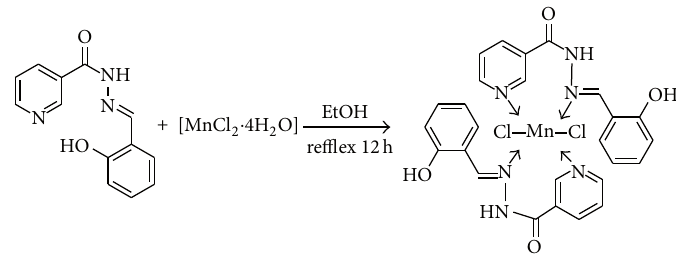
S 5: Route for the synthesis of the manganese